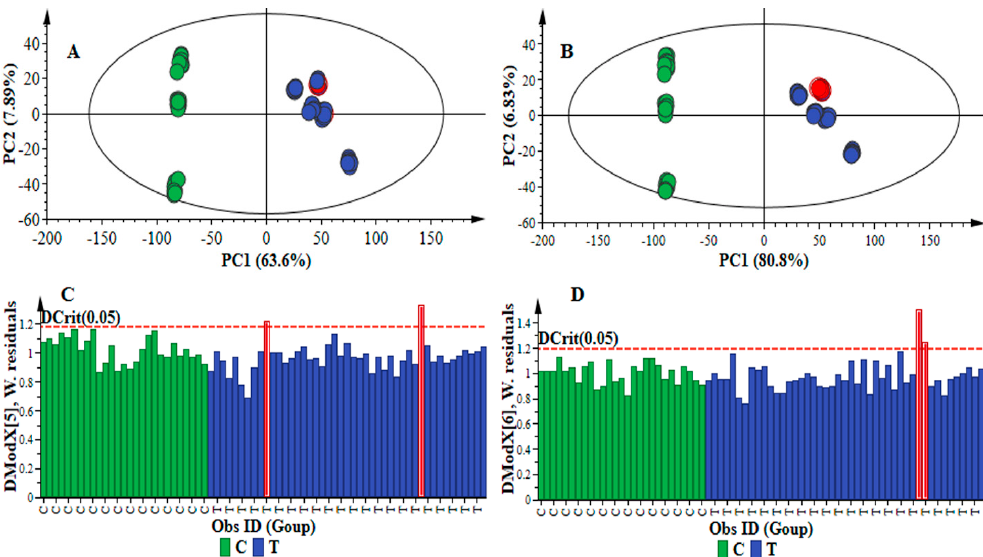
Figure 1. PCA score scatterplots and distance to the model (DModX) plot. ( A ) Score scatterplot of the PCA model of data X (processed with Method 1: Table 1): a five-component model, explaining 78.6% variation in the Pareto-scaled data and the amount of predicted variation by the model, according to cross-validation, is 74.6%; ( B ) Score scatterplot of the PCA model of data X (processed with Method 4 : Table 1): a 6-component model, explaining 93.4% variation in the Pareto-scaled data X and the amount of predicted variation by the model, according to cross-validation, is 91.7%; ( C ) The DModX plot of the PCA model in ( A ) showing the moderate outliers (in red); and ( D ) The DModX plot of the PCA model in ( B ) showing the moderate outliers (in